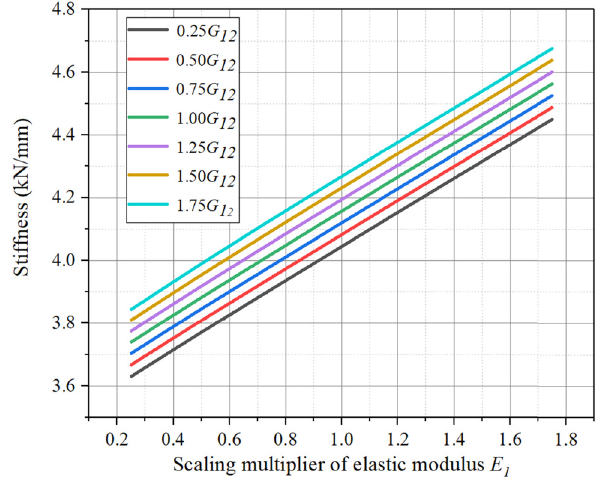
Figure 5: E ff ect of elastic constants on the sti ff ness characteristics.